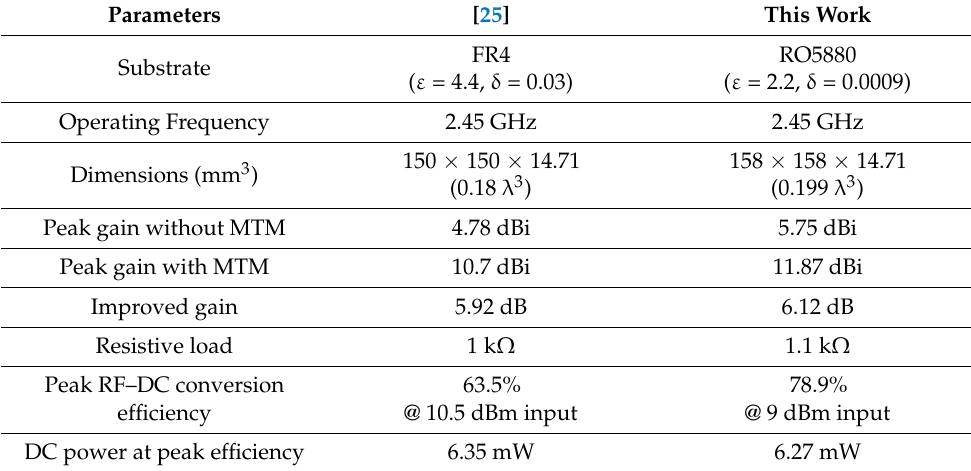
Table 3. Comparison of This Work with Preliminary Work.